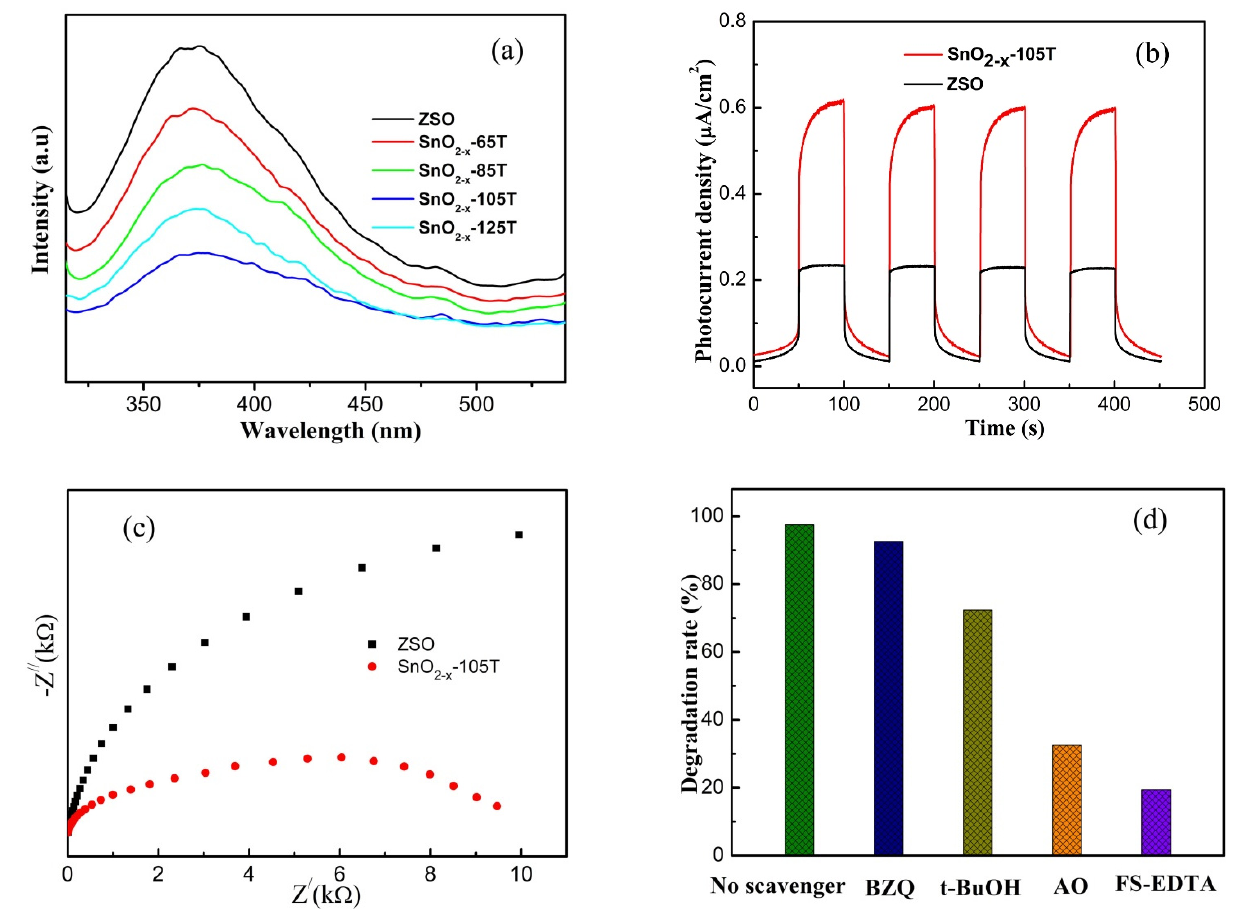
Figure 8. ( a ) PL spectra of the ZSO and SnO 2 − x samples; ( b ) transient photocurrents and ( c ) electrochemical impedance spectra ZSO and SnO 2 − x -105T of electrodes under visible light irradiation; ( d ) the effect of various scavengers on the visible light photocatalytic performance of the SnO 2 − x -105T sample.